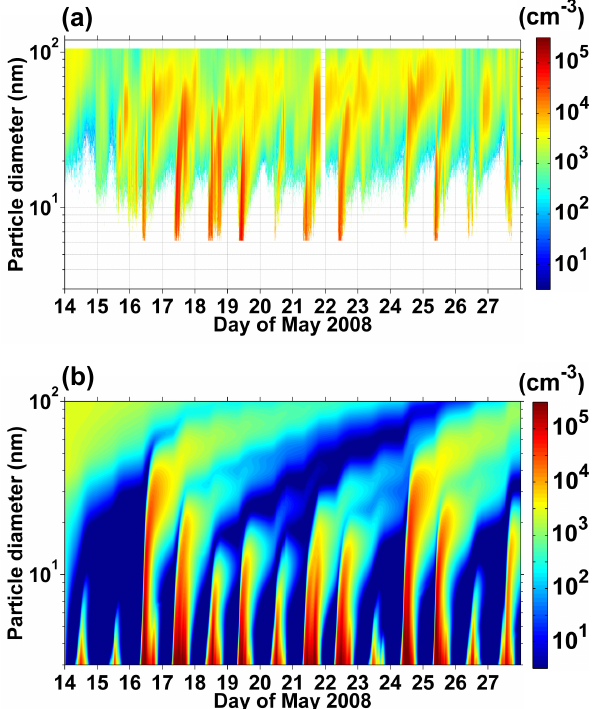
Fig. 9. Particle number size distribution [cm − 3 ], expressed as d N /dLog D p , (a) measured by the SMPS during the NIFTy exper- iment and (b) simulated. Model simulations have been performed setting 250 sections in order to match the size resolution of the SMPS and was initialized with the PSD observed on 14 May at 00:00